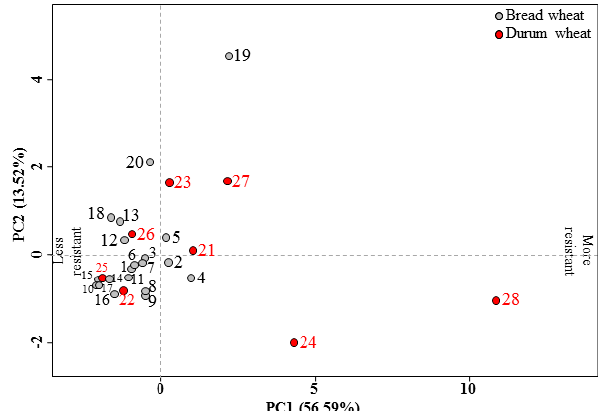
Figure 4. Plot of the first (PC1) and second (PC2) principal com- ponent means from an analysis of the 11 variables (percentage of plants resistant to each of the 11 Puccinia striiformis f. sp. tritici pathotypes, for 28 Lebanese landraces (1-28)), as described in Table 7. Gray symbols = bread wheat, red symbols = durum